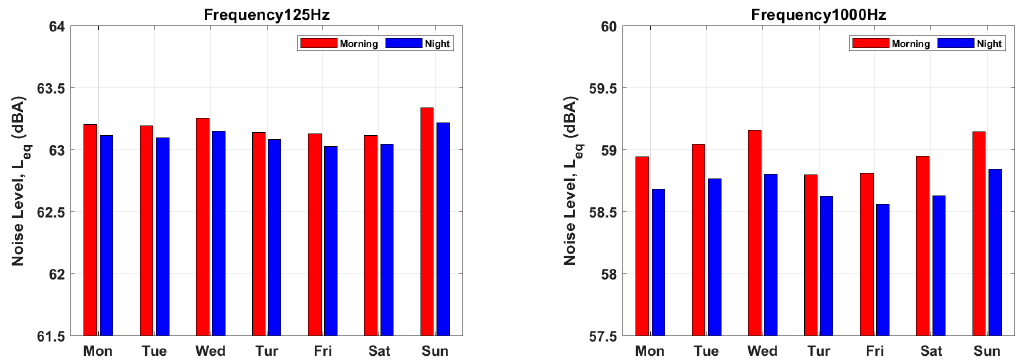
Figure 9. Morning and night average noise data vs. frequency (all sensor avg. vs. sensor 8).